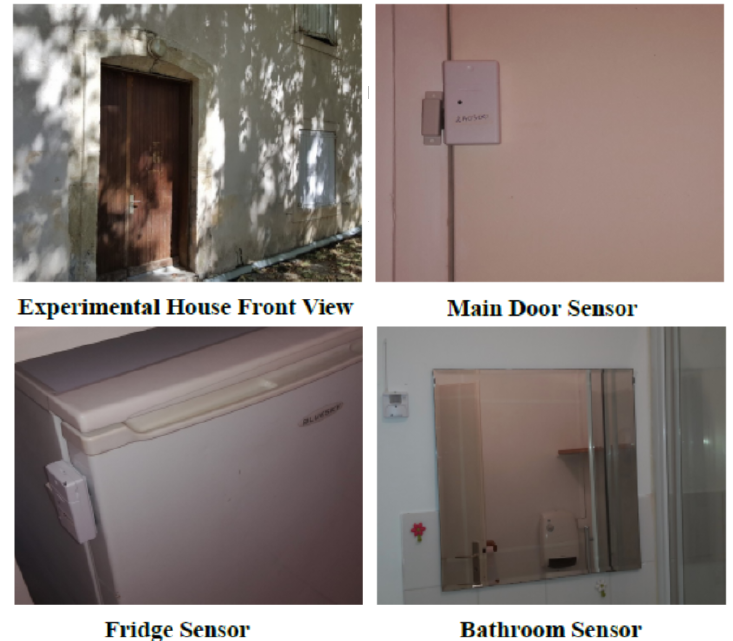
Figure 7. Montpellier pilot site demonstration house.